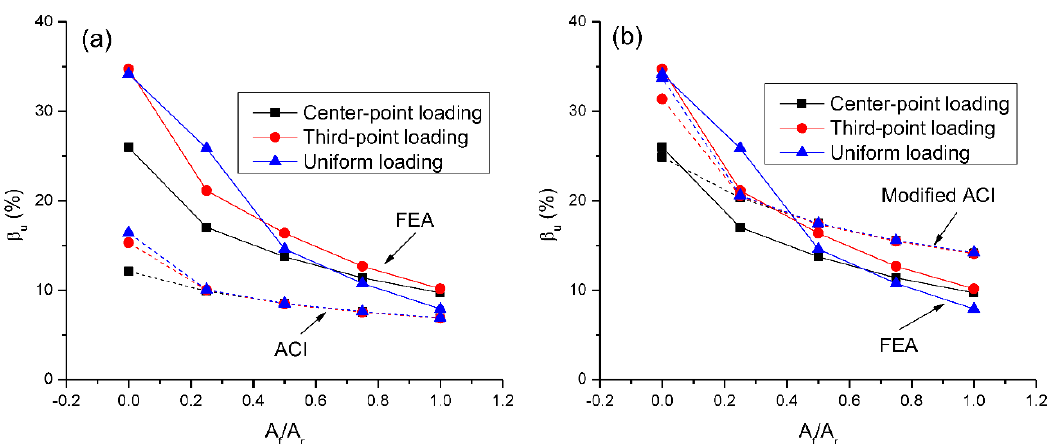
Figure 18. Comparison of β u - A f / A r relationships by FEA and simplified equations: ( a ) ACI equation; ( b ) modified ACI equation.